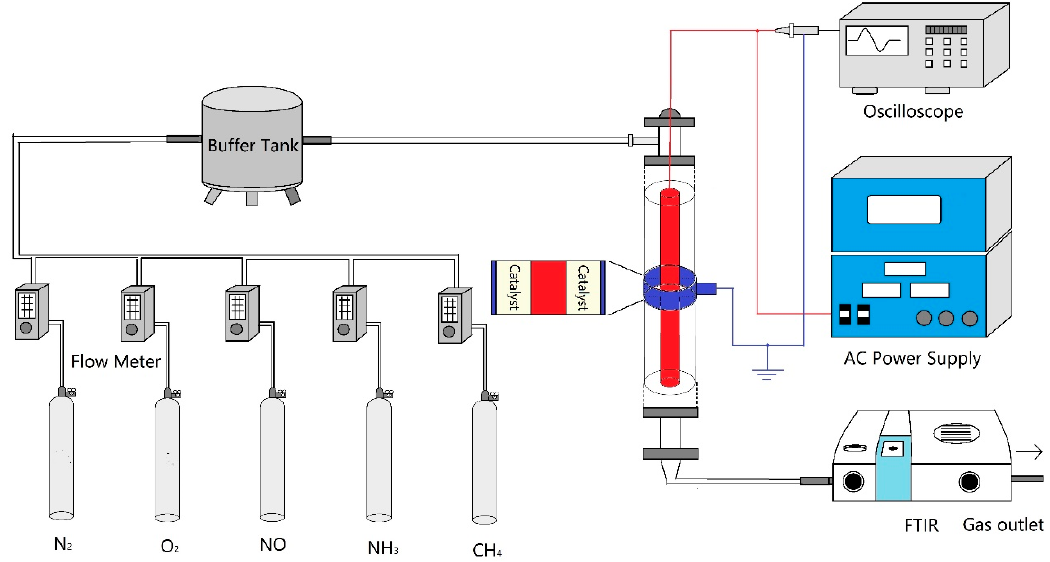
Figure 1. Schematic diagram of the experimental setup of the DBD–NH 3 –CH 4 –SCR